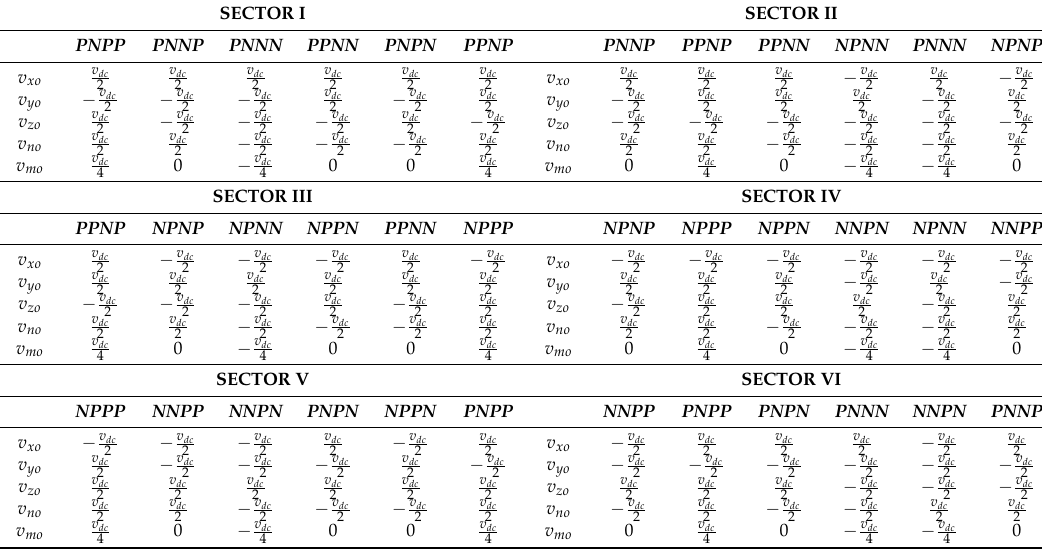
Table 3. Corresponding common mode voltage (CMV) based on the near state vector (NSV) of each